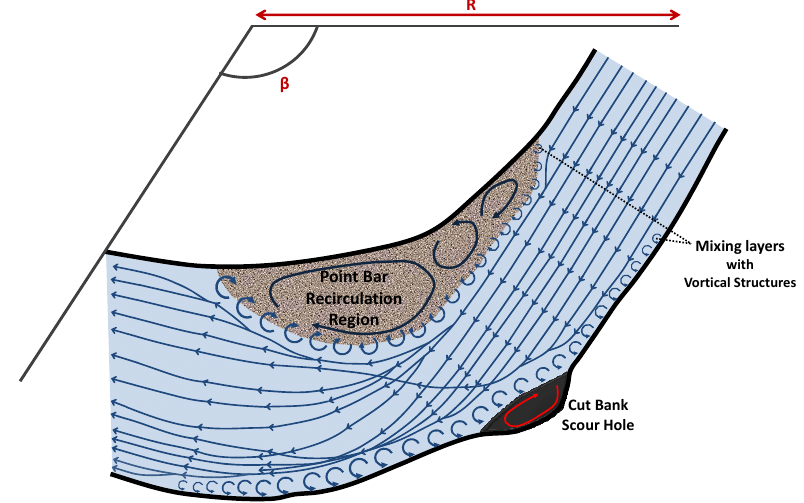
Fig. 13. Schematic of the flow field for a meander bend. (Figure adapted from the work of Kang and Sotiropoulos,